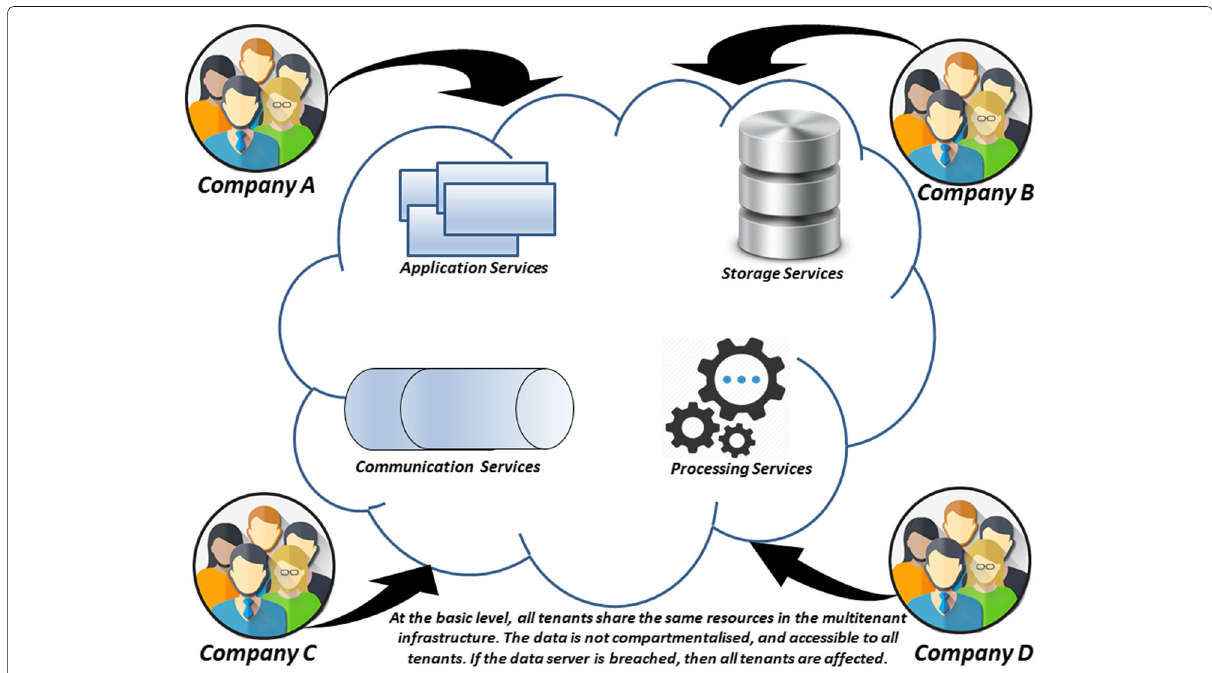
Fig. 1 Deploying Components of a Cloud-hosted Service in a Multitenant Infrastructure